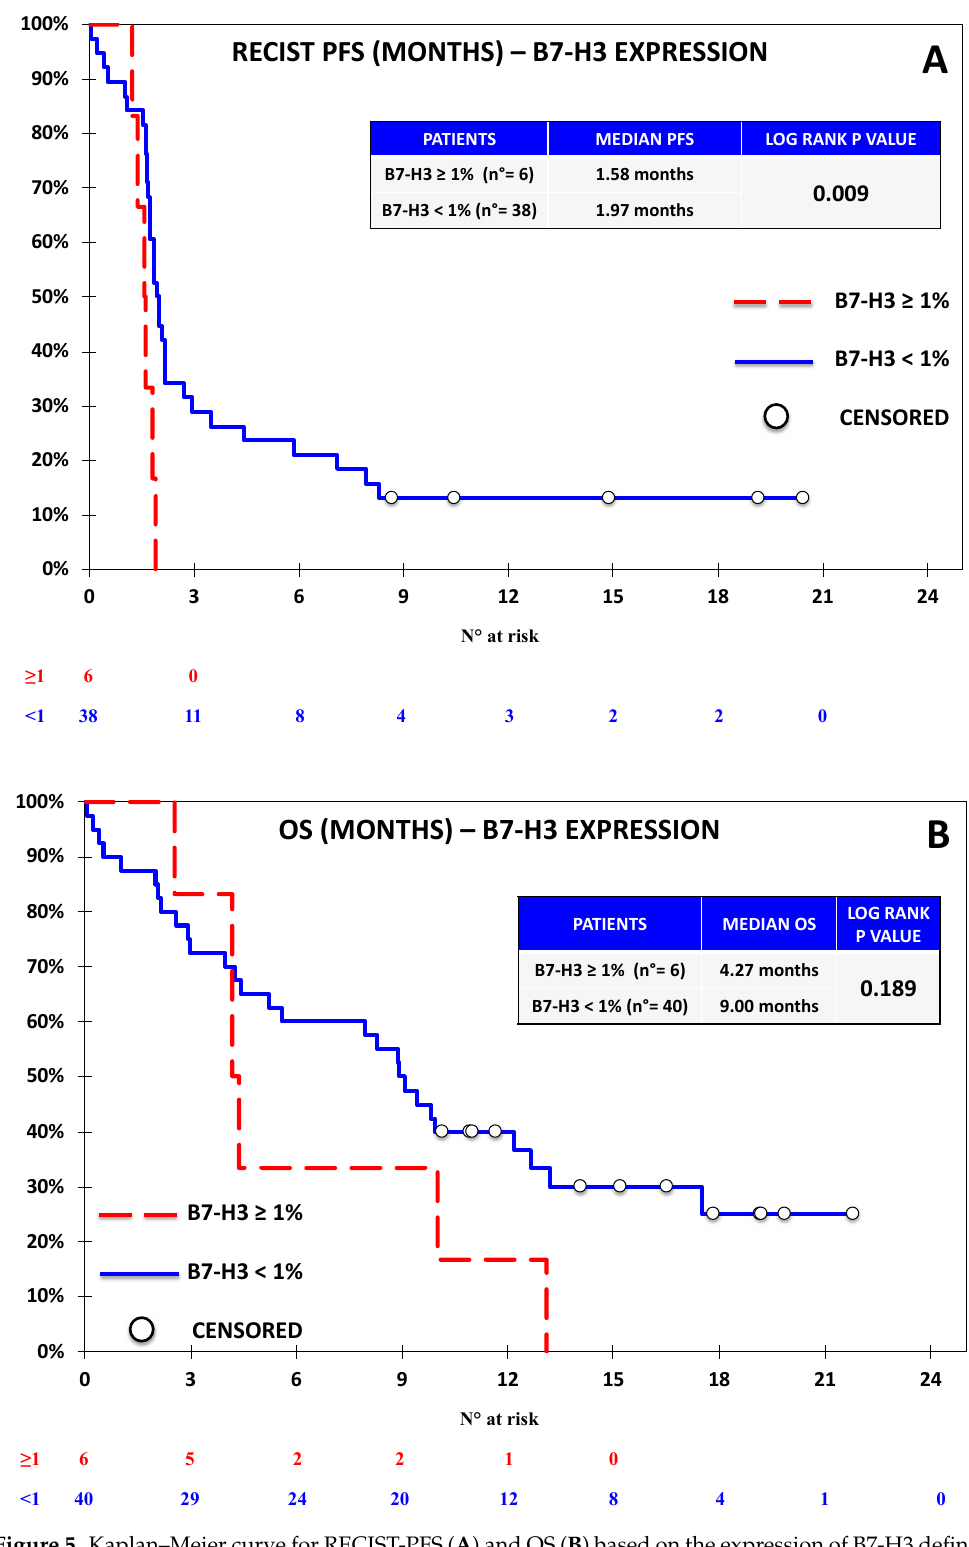
Figure 5. Kaplan–Meier curve for RECIST-PFS ( A ) and OS ( B ) based on the expression of B7-H3 defined as ≥ 1% vs. <1% in the Nivolumab Cohort. B7-H3 expression was associated with significantly lower RECIST-PFS and no significant difference in terms of OS. While these results should be considered with caution due to the fact that only six out of 44 patients expressed B7-H3, the rapid progression and death of all the B7-H3-expressing patients was noteworthy. Notably, all the patients who were alive at the time of the analysis did not express B7-H3.